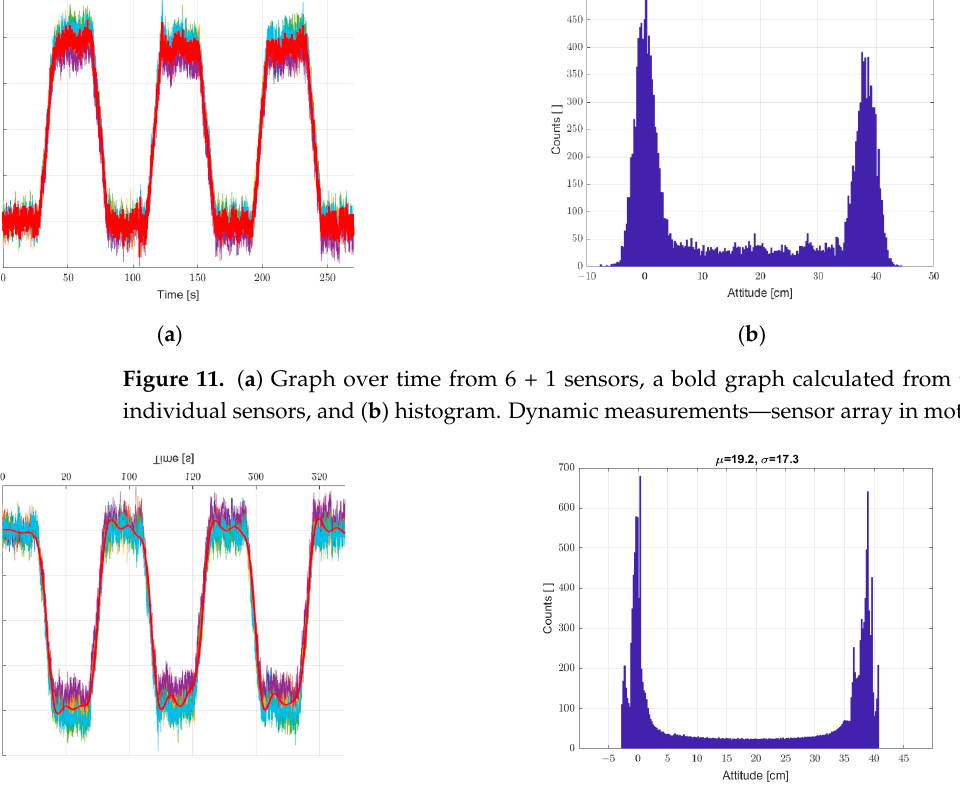
Figure 12. ( a ) Graph over time with 6 + 1, bold graph calculated from data averaged and filtered